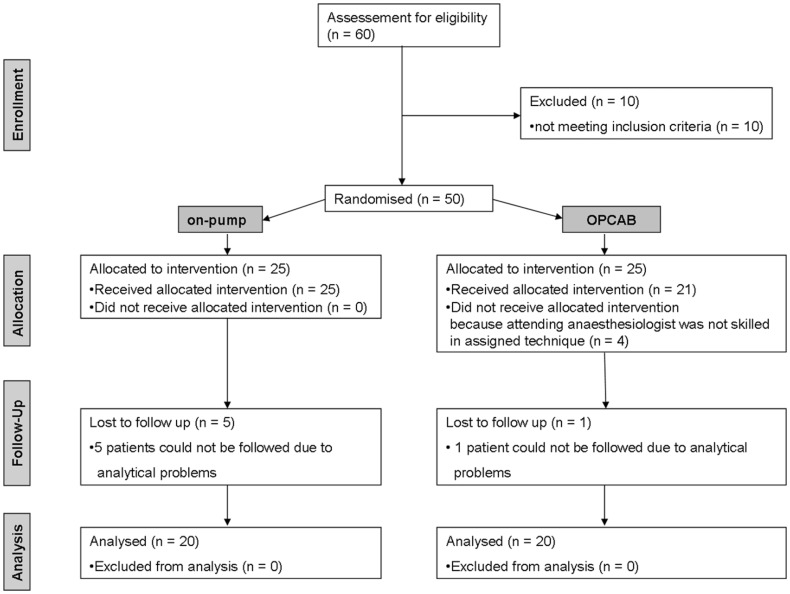
Flowchart.According to the CONSORT-statement for randomised clinical trials. From the initially screened 60 patients, 46 patients received the allocated intervention. 6 patients had to be excluded from further analysis.